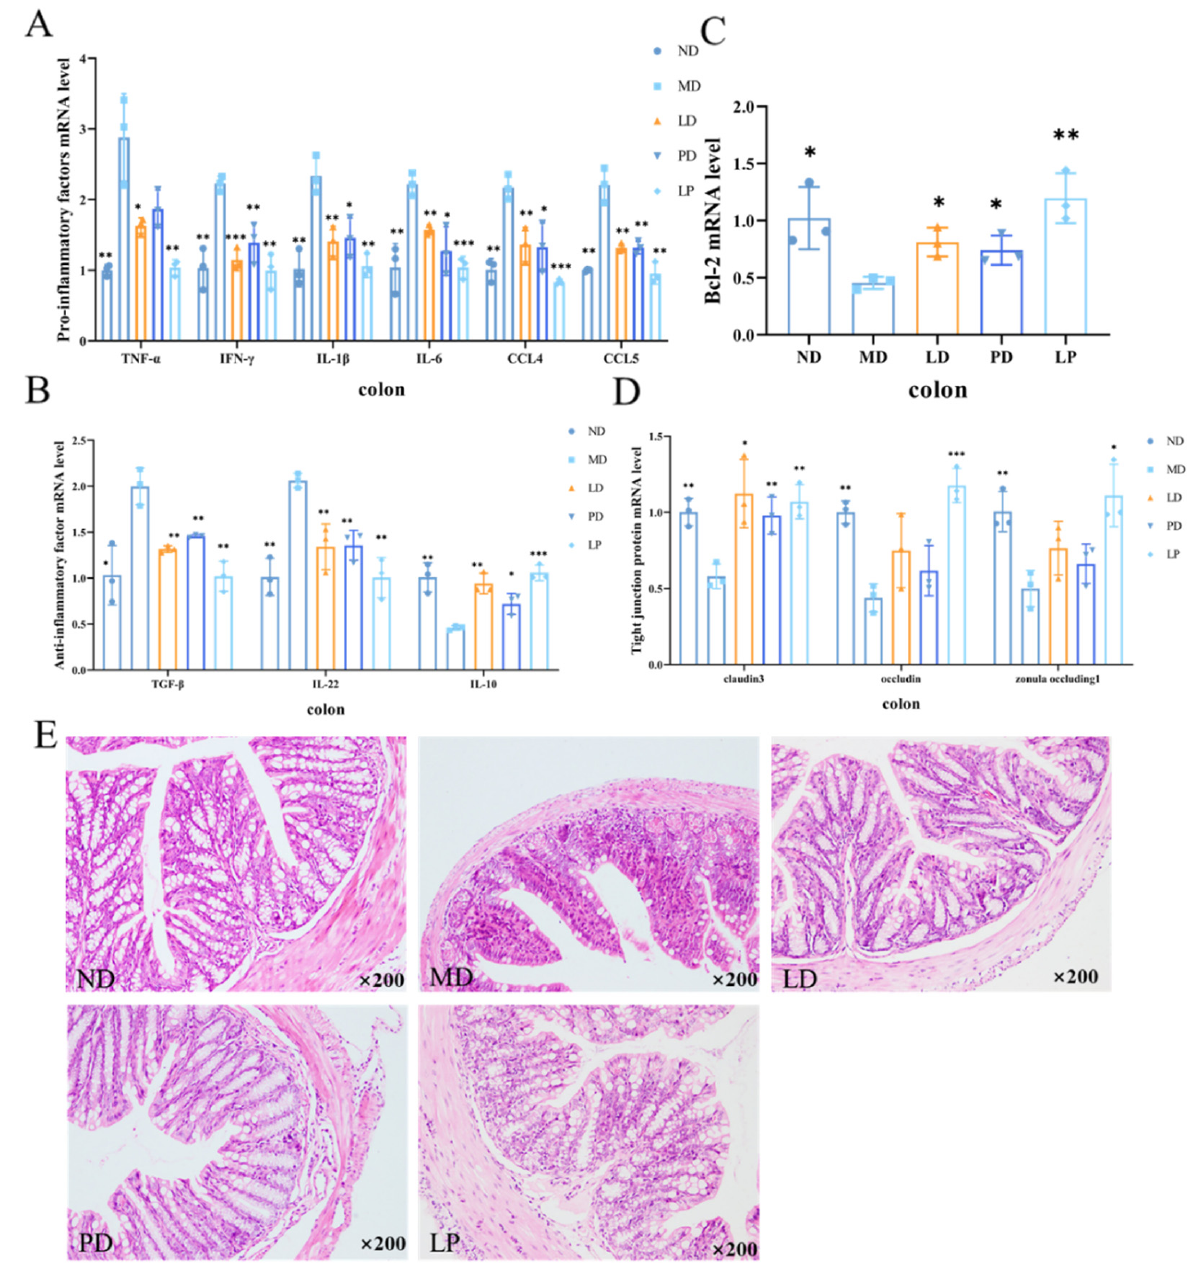
Figure 5. Synbiotics relieved intestinal inflammation in CCl 4 -induced ALI mice. ( A ) the expression levels of IFN- γ , IL-1 β , TNF- α , IL-6, CCL4, and CCL5 in the colon tissues ( n = 3). ( B ) the expression levels of IL-10, IL-22, and TGF- β in the colon tissues ( n = 3). ( C ) the mRNA level of Bcl-2 ( n = 3). ( D ) the mRNA levels of claudin3, occludin, zonula occludin-1 ( n = 3). ( E ) H&E pathological section of the mouse colon tissue ( n = 4). * p < 0.05; ** p < 0.01; *** p < 0.001; * is compared with MD; paired two-tailed t -test.